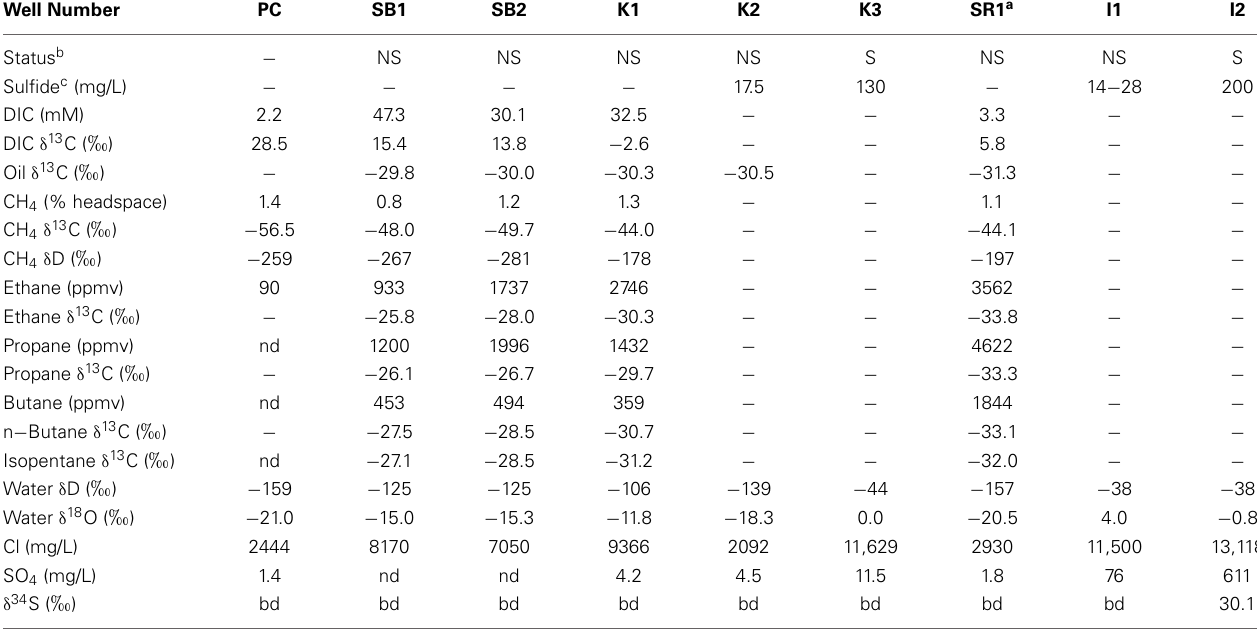
Table 2 | Chemical and isotopic data for produced water